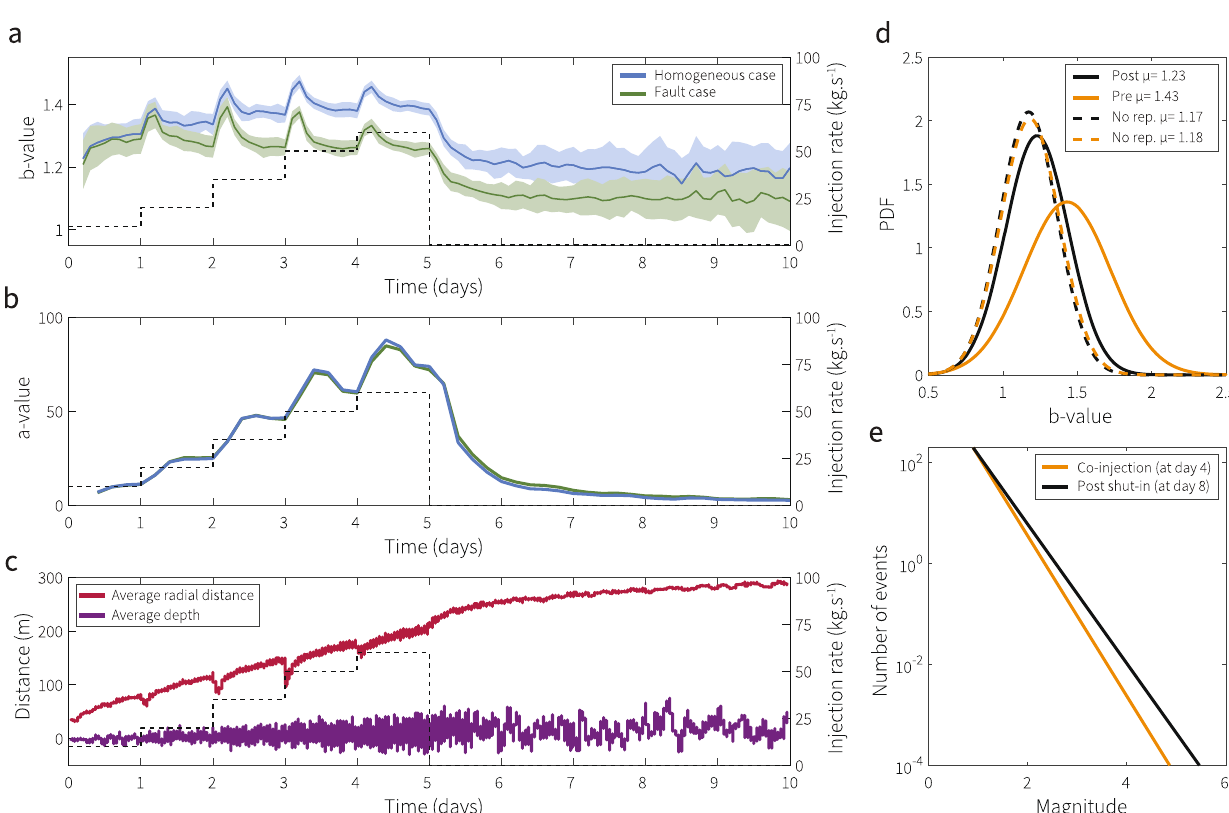
Fig. 3 Statistical analysis of the simulated seismicity for the step-increasing injection. a Temporal evolution of the b -value with a fi xed time-window (0.2 days, moving average with a 0.1 days overlap; shaded area ± one standard deviation) for the homogeneous and fault cases; b Hourly a -value for the homogeneous and fault cases. For the homogeneous case: c Average spatial distribution of events over time; d Distribution of b -values during injection (light) and after shut-in (dark); the dashed lines do not include previously reactivated seeds; e Frequency-magnitude distribution of 200 events at 4 days (co-injection) and 8 days (after